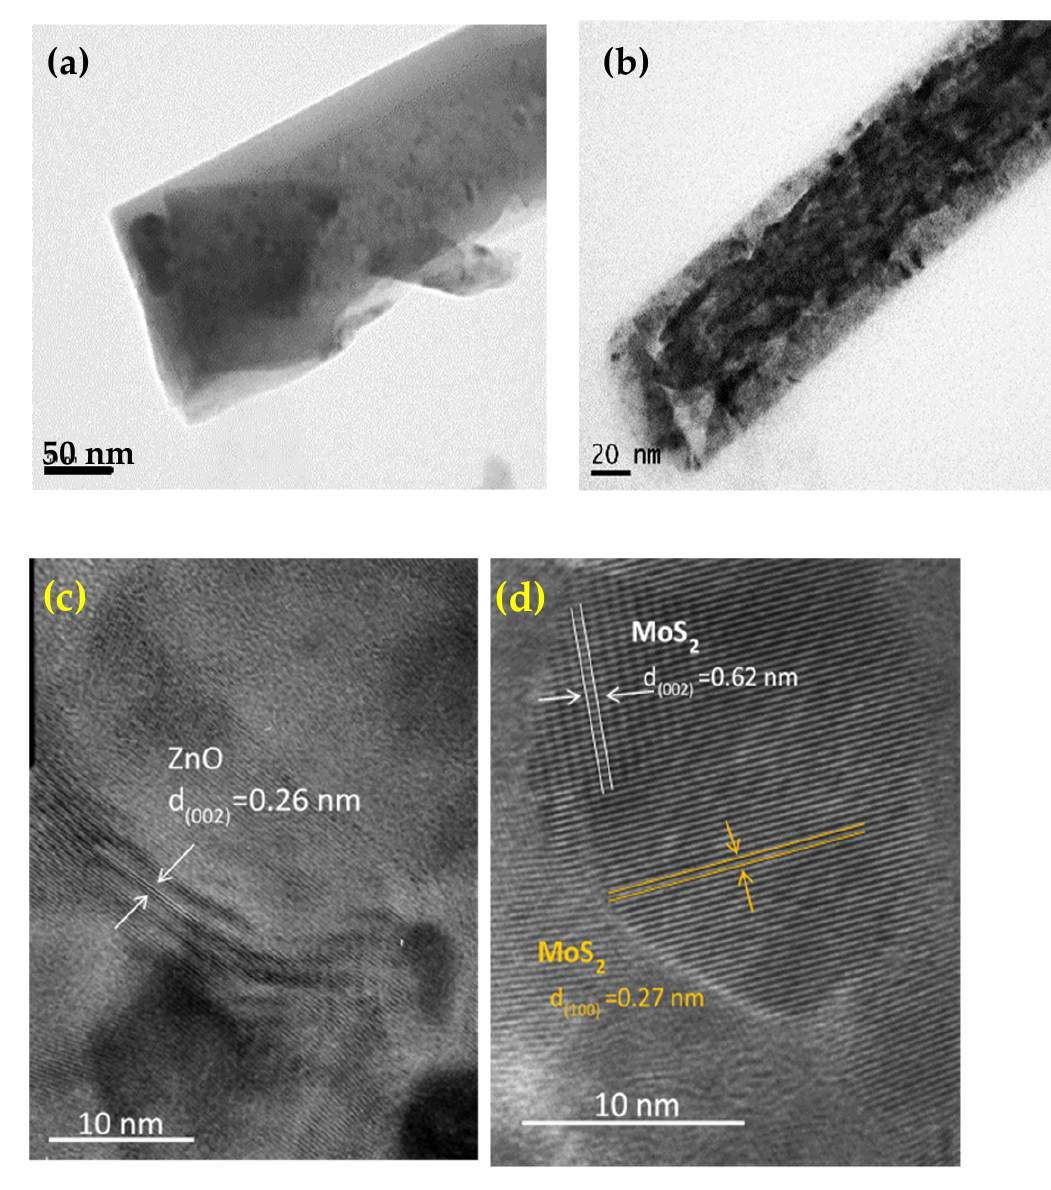
Figure 2. TEM images ( a ) a ZnO NW and ( b ) a ZnO/MoS 2 core/sheath heterostructure. HRTEM of ( c ) ZnO and ( d ) hexagonal MoS 2 showing the crystal planes (002) and